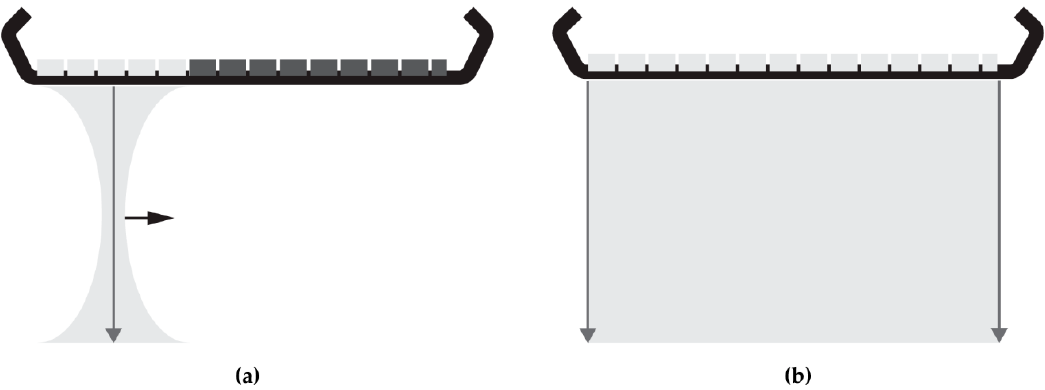
Figure 1. Illustrations of: ( a ) a focused acquisition series in which the aperture (active elements in light gray) is shifted to acquire data line-by-line by transmitting a focused ultrasound beam and receiving the reflected signal for each aperture position; ( b ) a plane-wave acquisition, where an unfocused ultrasound is transmitted and reflected signals are received by the full transducer aperture.